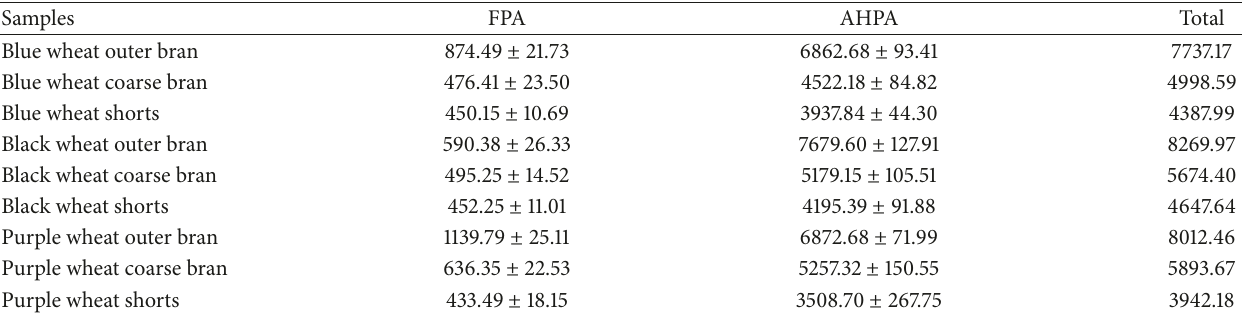
Table 3: Total phenolic content ( 𝜇 g GAE/g defatted bran) of free and bound phenolic acids in the bran fractions of three pigmented wheat varieties.